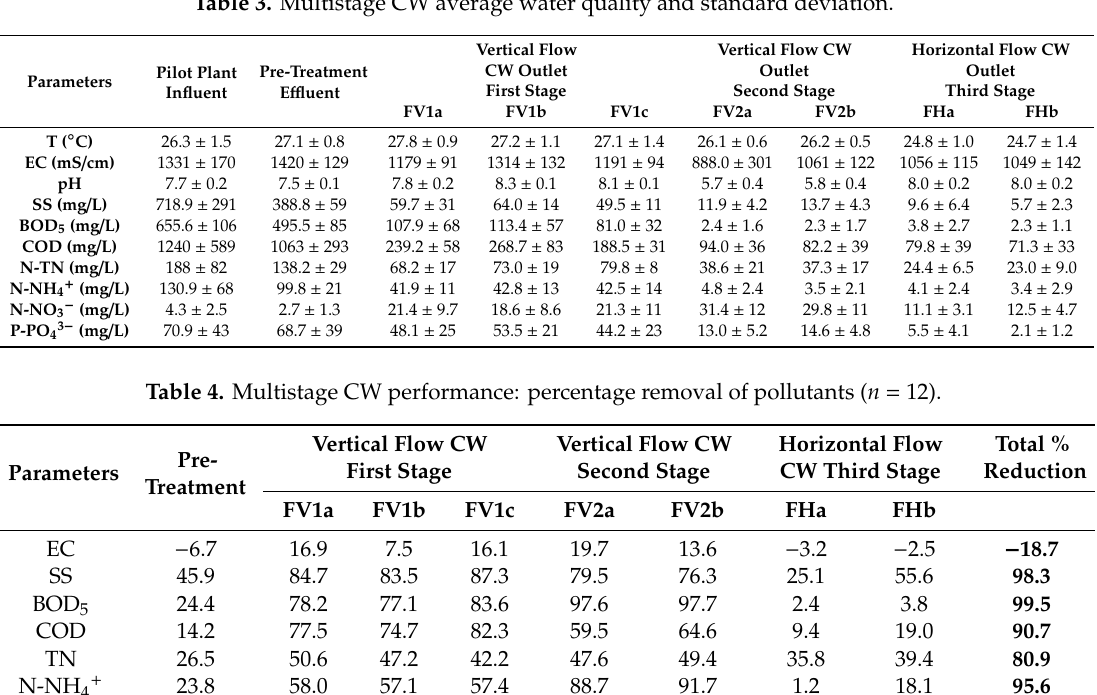
Table 3. Multistage CW average water quality and standard deviation.